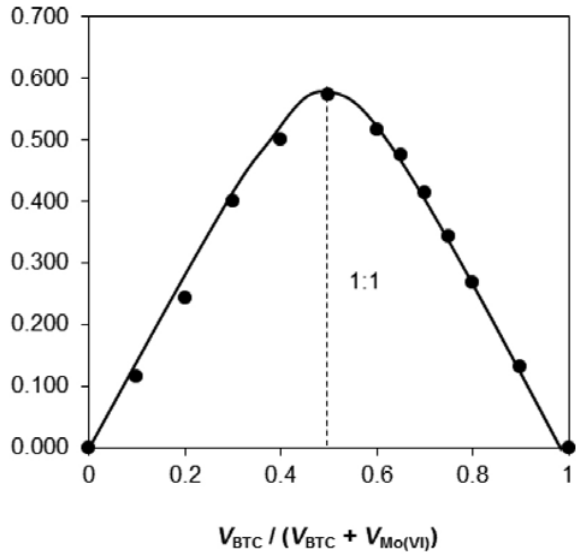
+ C = 1.04 × 10 -4 mol Mo(VI) BTC = 4.0 × 10 –1 mol L –1 ; λ = H2SO4